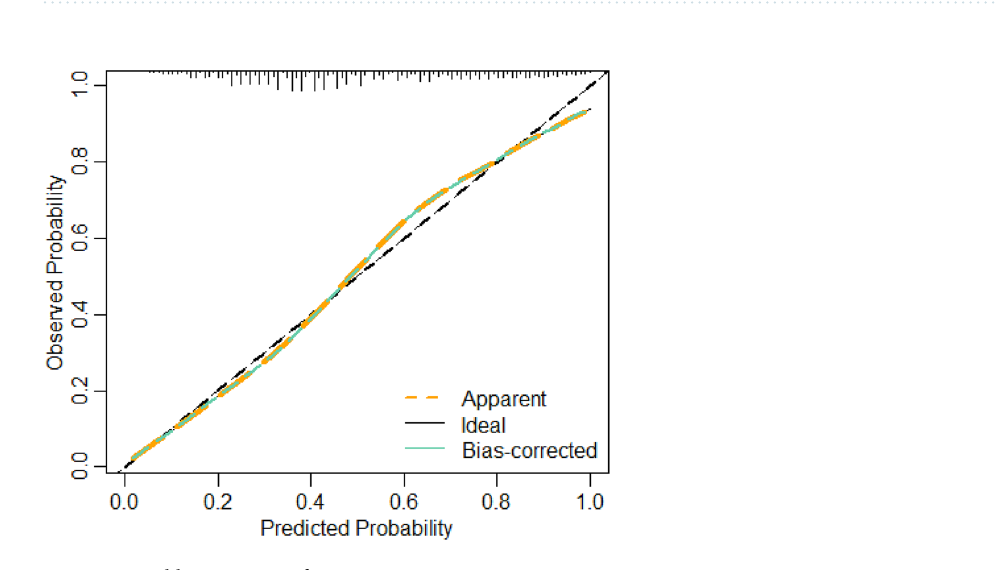
Figure 6. Calibration curve for